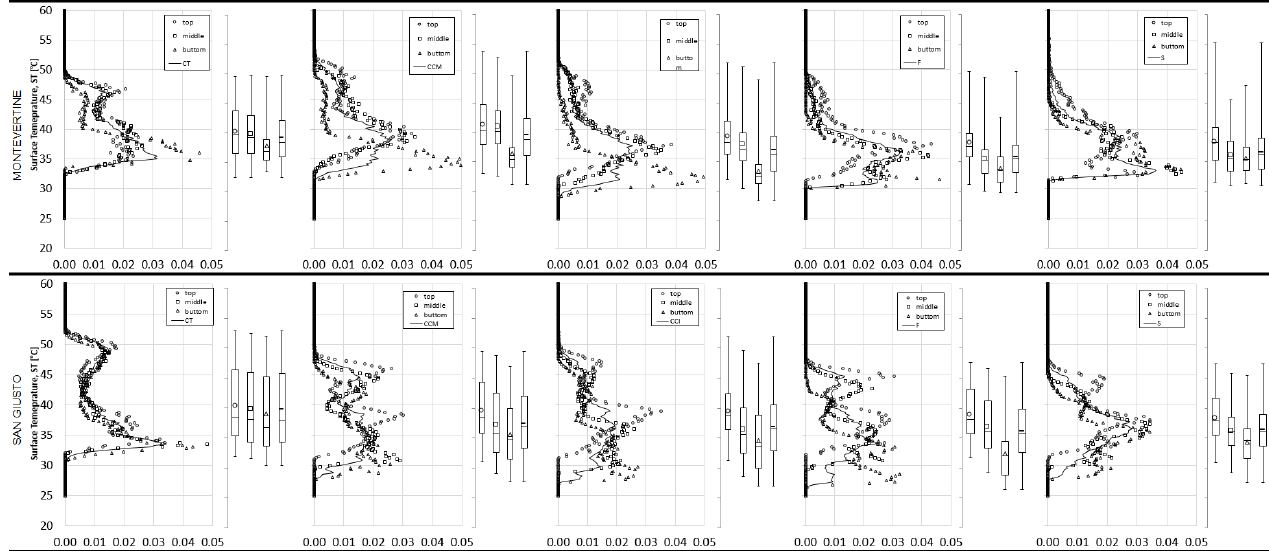
Figure 10. Distributions frequency and boxplots of the surface temperature pixels obtained for the entire treatment row and for the three subplots (top; middle; bottom).